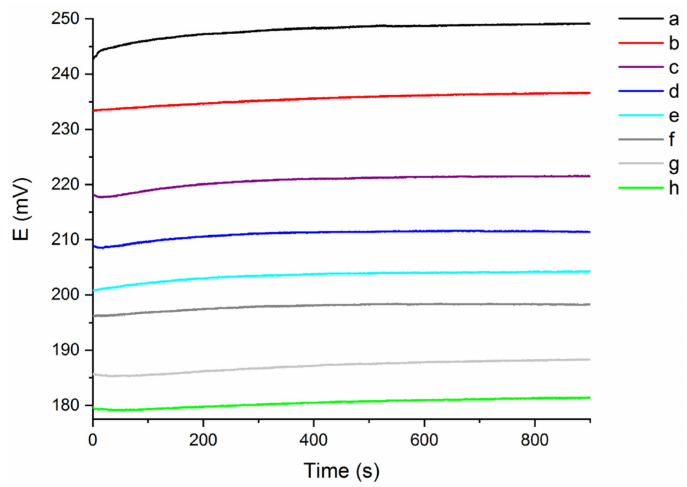
Figure 1. OCP signal recorded for 900 s in 10 ◦ fH solutions, with different chloride content (a: 5 mg/L; b: 10 mg/L; c: 20 mg/L; d: 30 mg/L; e: 40 mg/L; f: 50 mg/L; g: 75 mg/L; h: 100